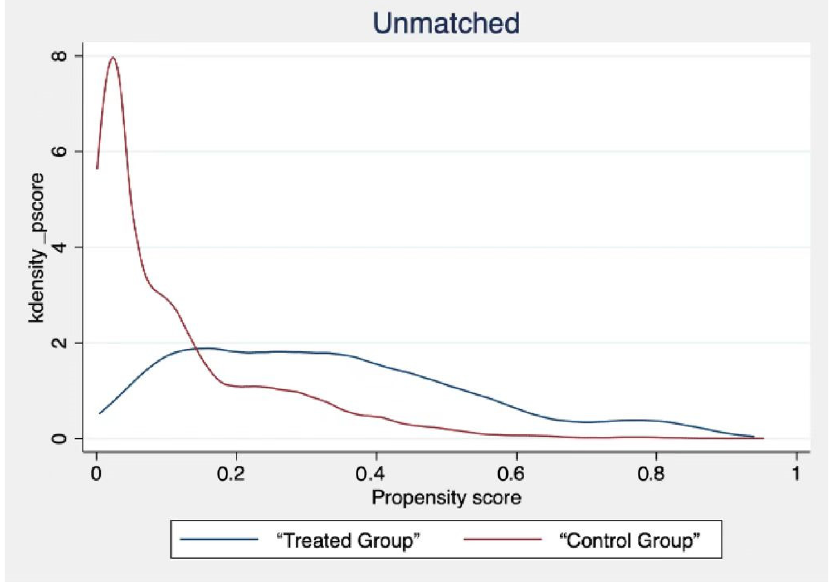
Figure 3. Kernel density function before matching.